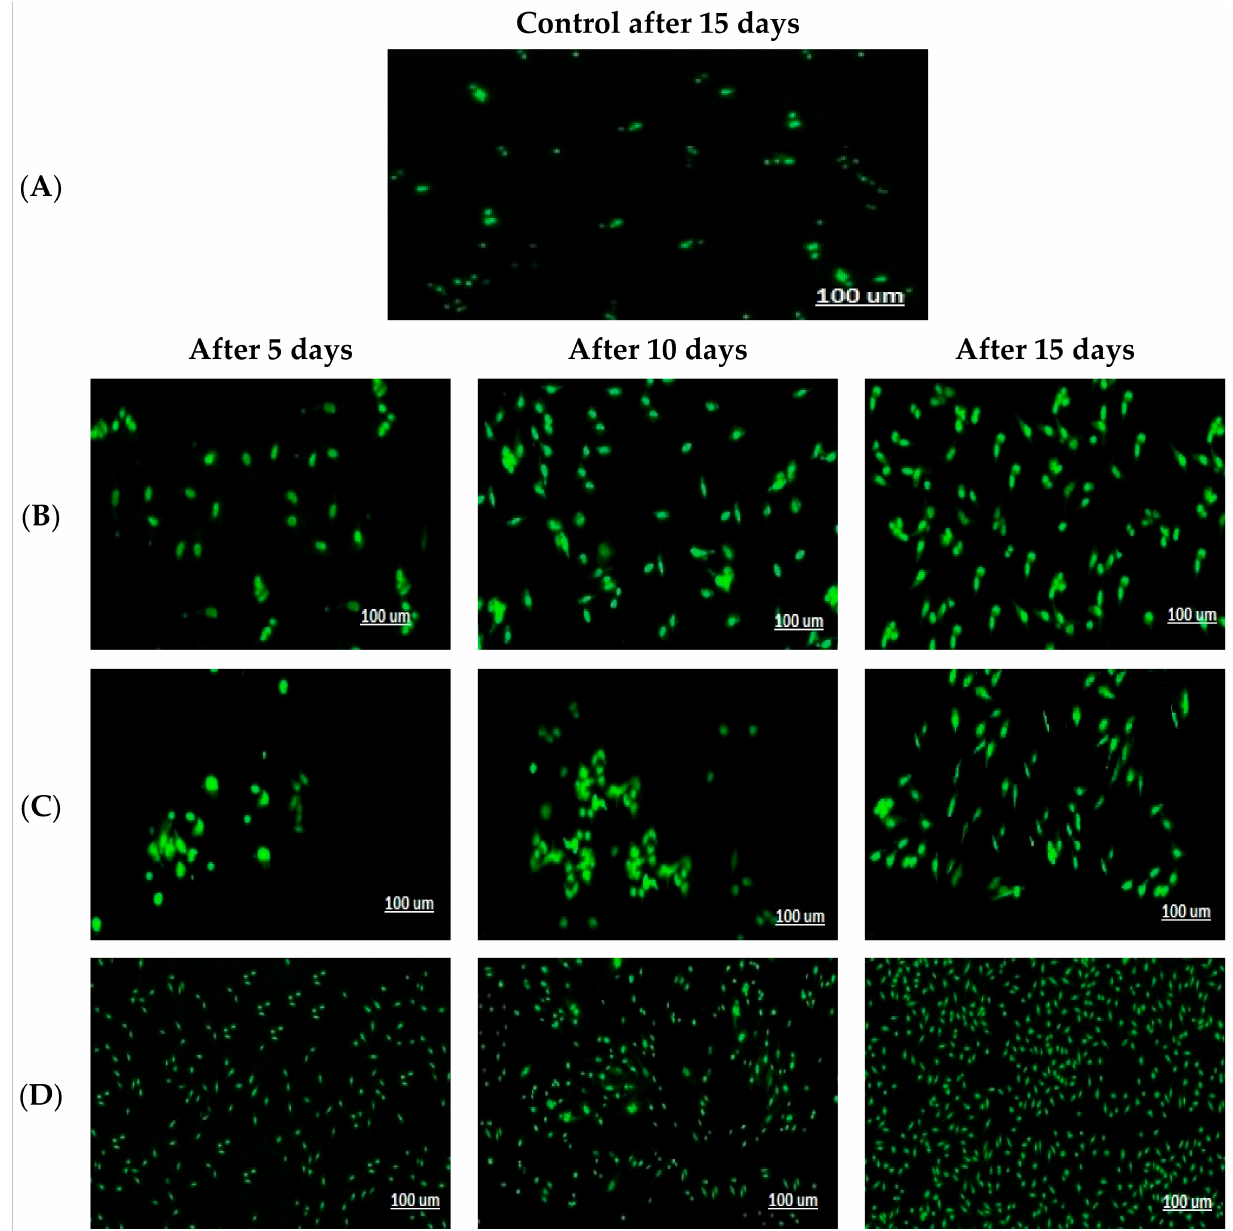
Figure 6. Fluorescence microscope images ( × 100) for HDFa proliferation of HDFa cells treated with: ( B ) NVH-suspension; ( C ) blank chitosomal formulation, and ( D ) NVH-loaded chitosomal formulation F6 after 5 days, 10 days and 15 days of incubation, and control ( A ) after 15